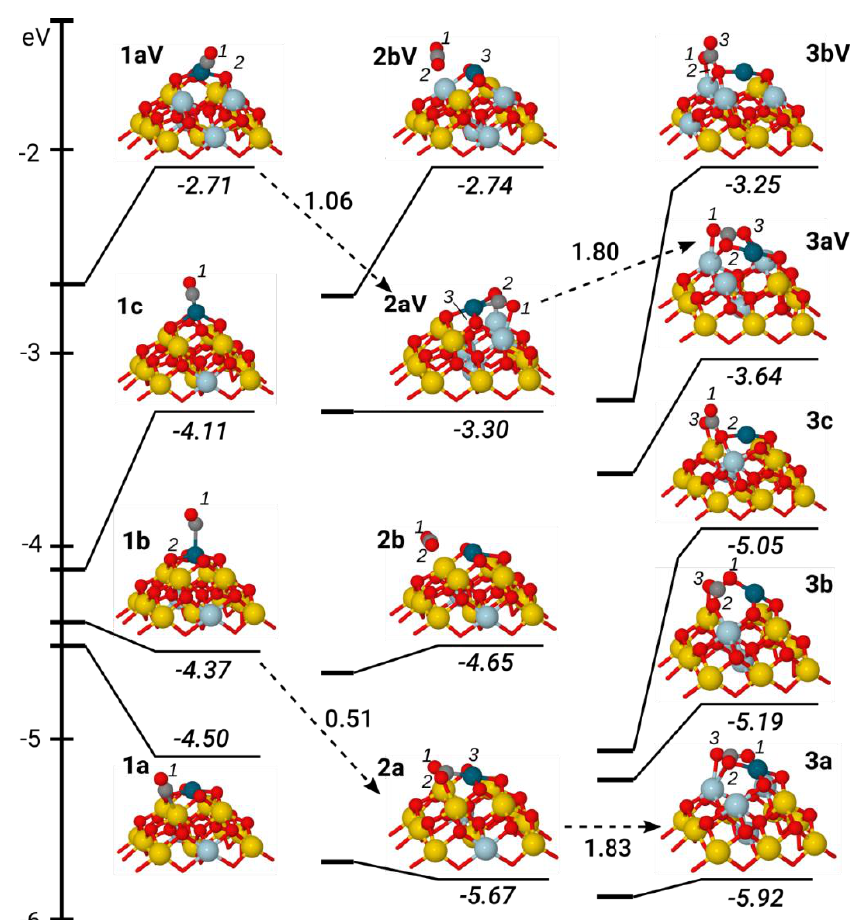
Figure 3. Structures and formation energies E f (in eV) of the complexes created by the interaction of CO with the PdCe 21 O 42−n sites (n = 0, 1): PdCO/Ce 21 O 42 ( Pd1a, Pd1b, Pd1c ), PdCO/Ce 21 O 41 ( Pd1aV ), PdCO 2 /Ce 21 O 41 ( Pd2a, Pd2b ), PdCO 2 /Ce 21 O 40 ( Pd2aV, Pd2bV ), PdCO 3 /Ce 21 O 40 ( Pd3a, Pd3b, Pd3c ) and PdCO 3 /Ce 21 O 39 ( Pd3aV, Pd3bV ). Activation energies (E ≠ ) of selected transition states are shown near the dashed arrows connecting corresponding initial reagent and product. For further explanations, refer to the main text and the captions to Figures 1 and 2.